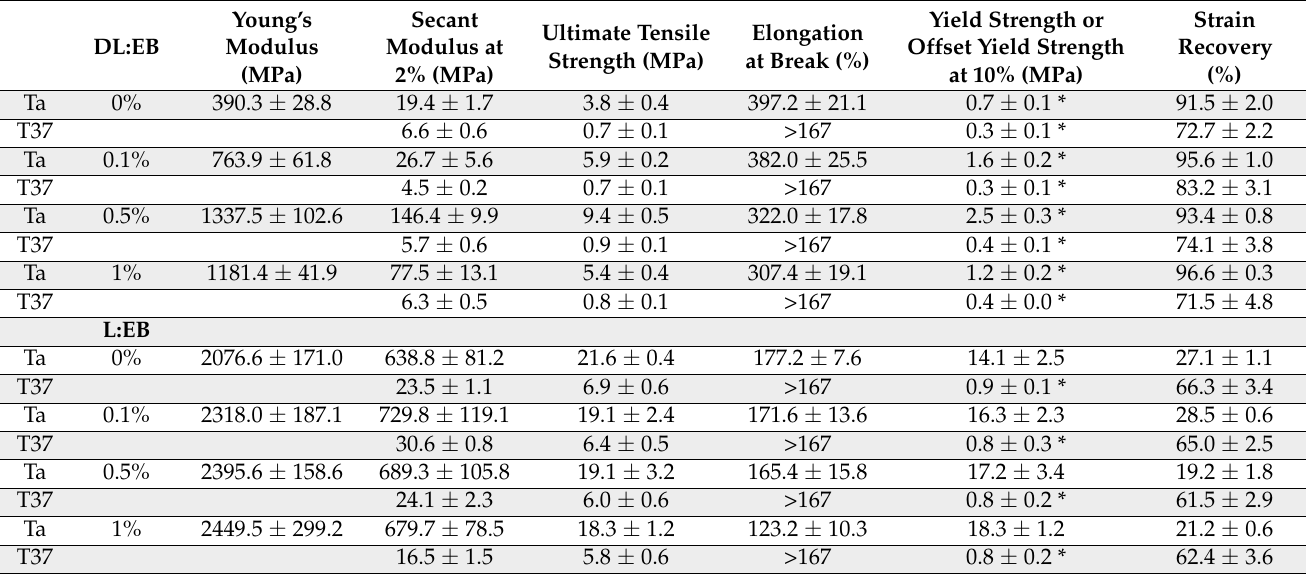
Table 4. Mechanical properties of the resulting films at ambient temperature (Ta) and body tempera- ture